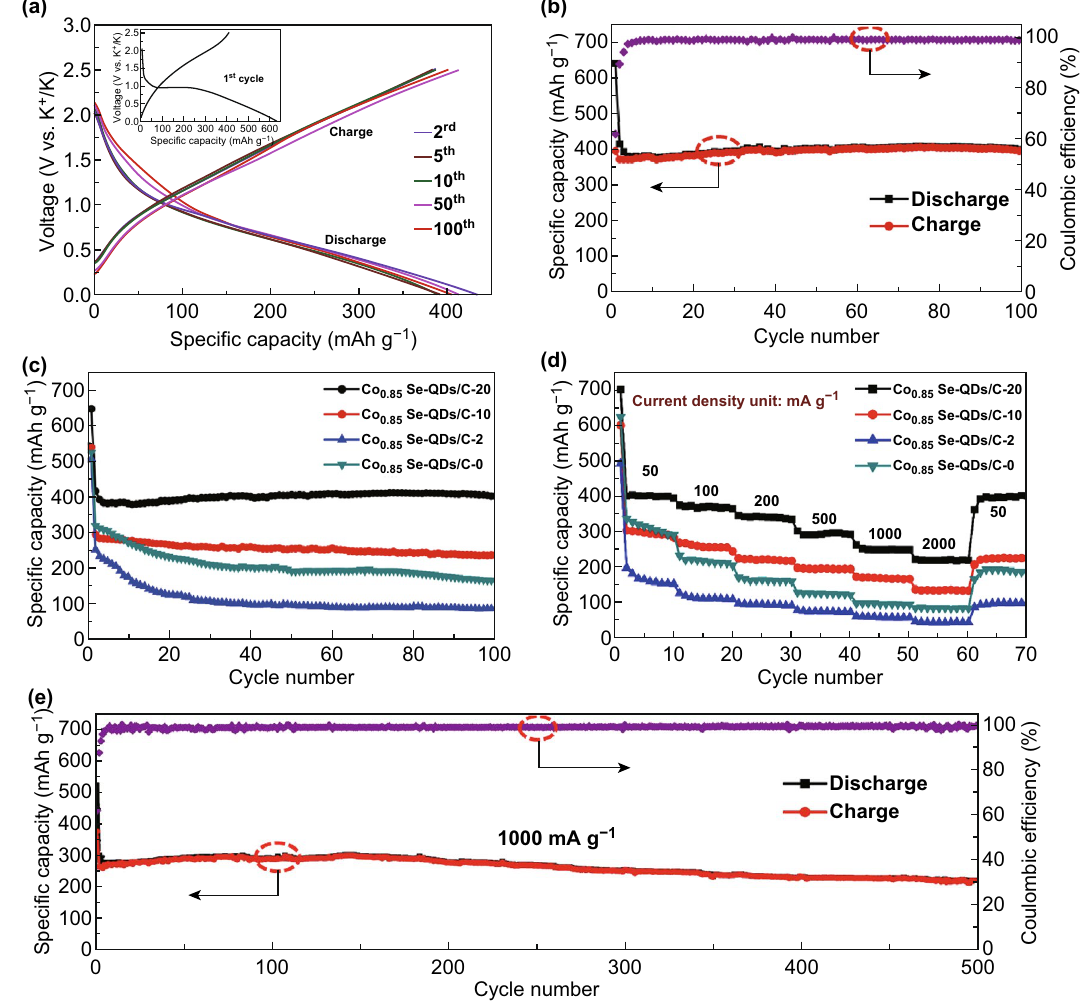
Fig. 4 Electrochemical potassium storage performance of Co 0.85 Se‑QDs/C composite. a The second, third, fifth, tenth, fiftieth, and hundredth charge/discharge profiles of Co 0.85 Se‑QDs/C‑20 at 50 mA g −1 for KIBs (inset is the charge/discharge profiles of the first cycle). b Charge/dis‑ charge capacity and Coulombic efficiency of Co 0.85 Se‑QDs/C‑20 at 50 mA g −1 . Comparison between c cycling stability and d rate performance under different current densities of the as‑prepared Co 0.85 Se‑QDs/C samples. e Long‑term cycling stability and Coulombic efficiency at a high current density of 1 A g −1 over 500